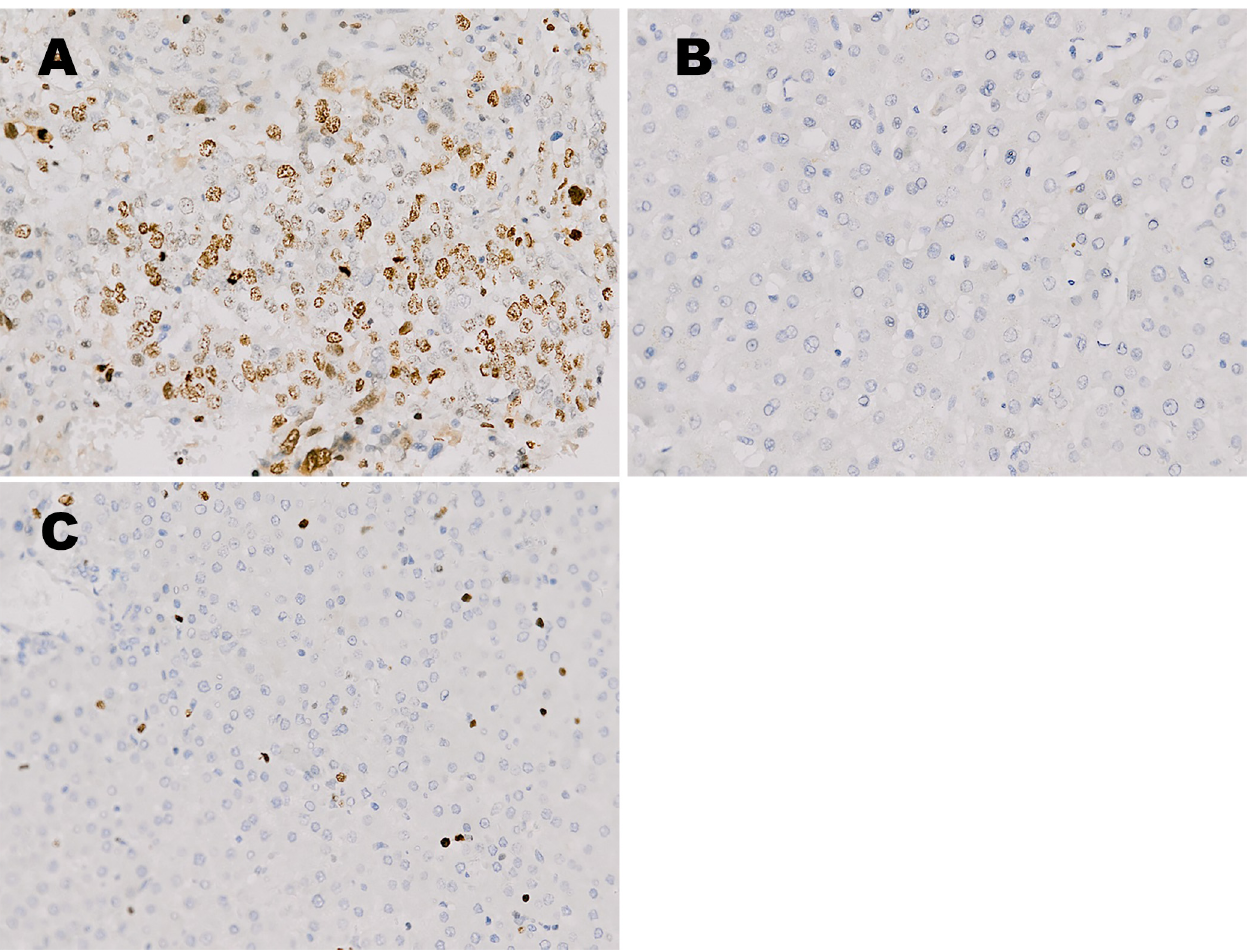
Fig 2. Expression of Ki-67 in human primary hepatocellular carcinoma. Immunohistochemical staining of CK-19 in (A) tumor tissues, (B) adjacent non- malignant tissues, and (C) liver cirrhosis tissues. Representative illustrations are shown. Magnification: